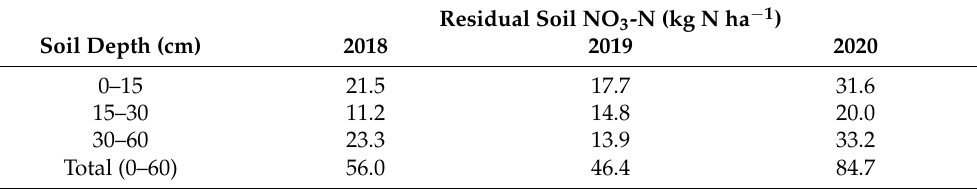
Table 1. Residual soil nitrate-nitrogen (NO 3 -N) across soil depths from 2018 to